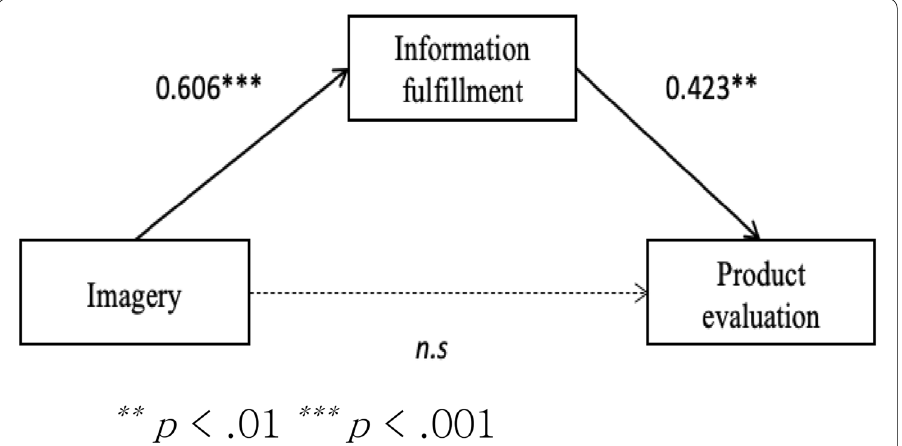
Fig. 3 Mediation of information fulfillment in the effect of imagery on product